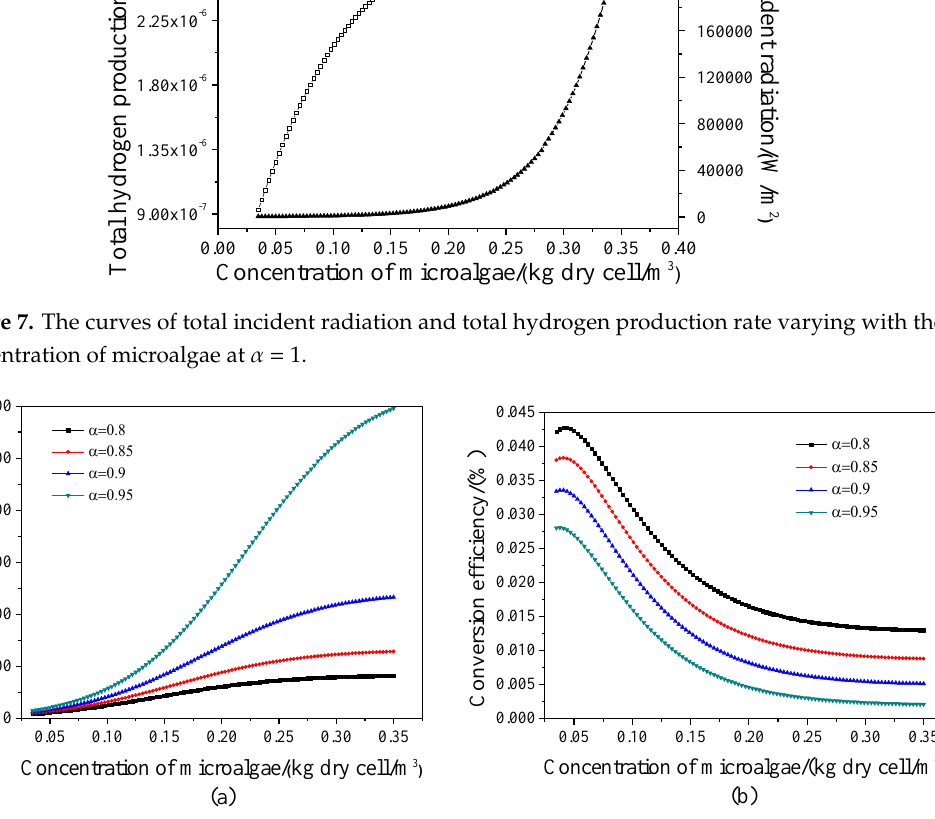
Figure 8. ( a ) The curves of total LED incident radiation with the concentration of microalgae and the dimensionless hydrogen production rate; ( b ) the curves of conversion efficiency of light energy to hydrogen energy with the concentration of microalgae and the dimensionless hydrogen production rate.